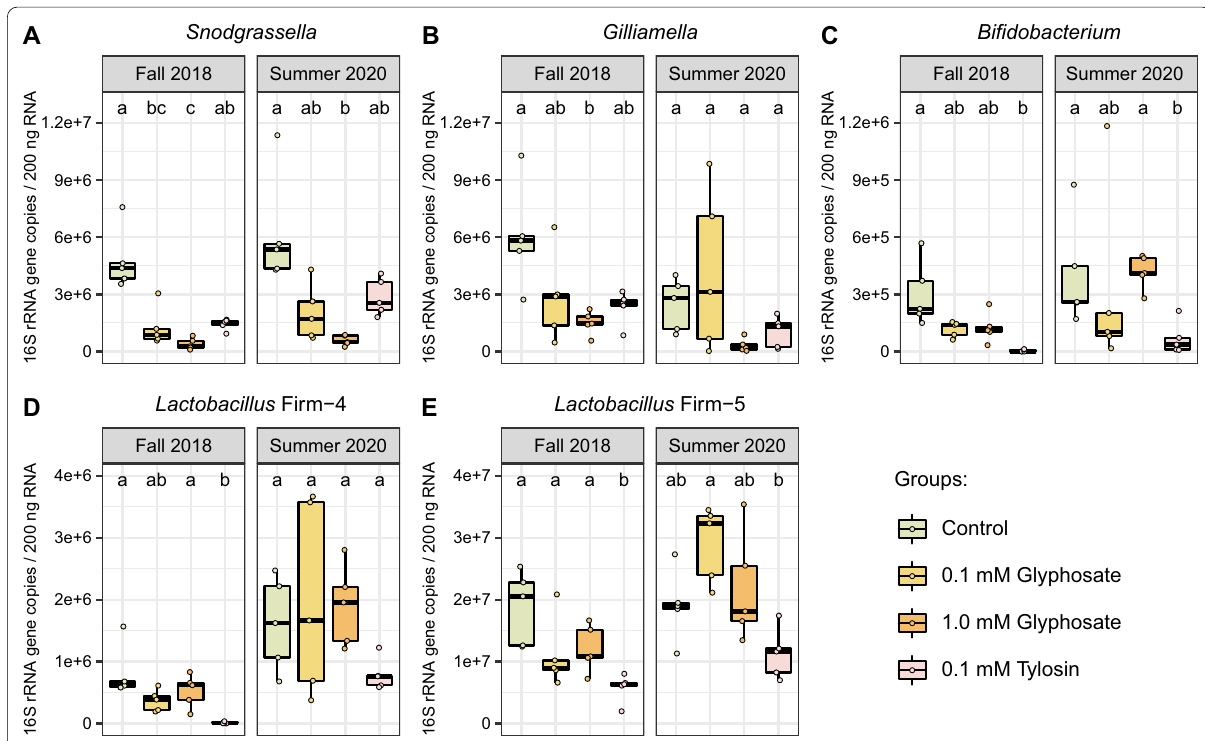
Fig. 3 Effects of glyphosate or tylosin exposure on the gut microbiota of honey bees in the fall 2018 and summer 2020 experiments. A – E Changes in the abundance of 16S rRNA gene transcripts for A Snodgrassella , B Gilliamella , C Bifidobacterium , D Lactobacillus Firm-4, and E Lactobacillus Firm-5 in the guts of honey bees exposed to 0.1 mM glyphosate, 1.0 mM glyphosate or 0.1 mM tylosin for 5 days, when compared to unexposed, control bees. Each group consists of 5 samples, each representative of 3 bee guts. Each experiment was analyzed individually, and significance of differences among groups was measured with Kruskal–Wallis tests followed by Dunn’s multiple-comparison tests. Groups with different letters are significantly different at p < 0.05